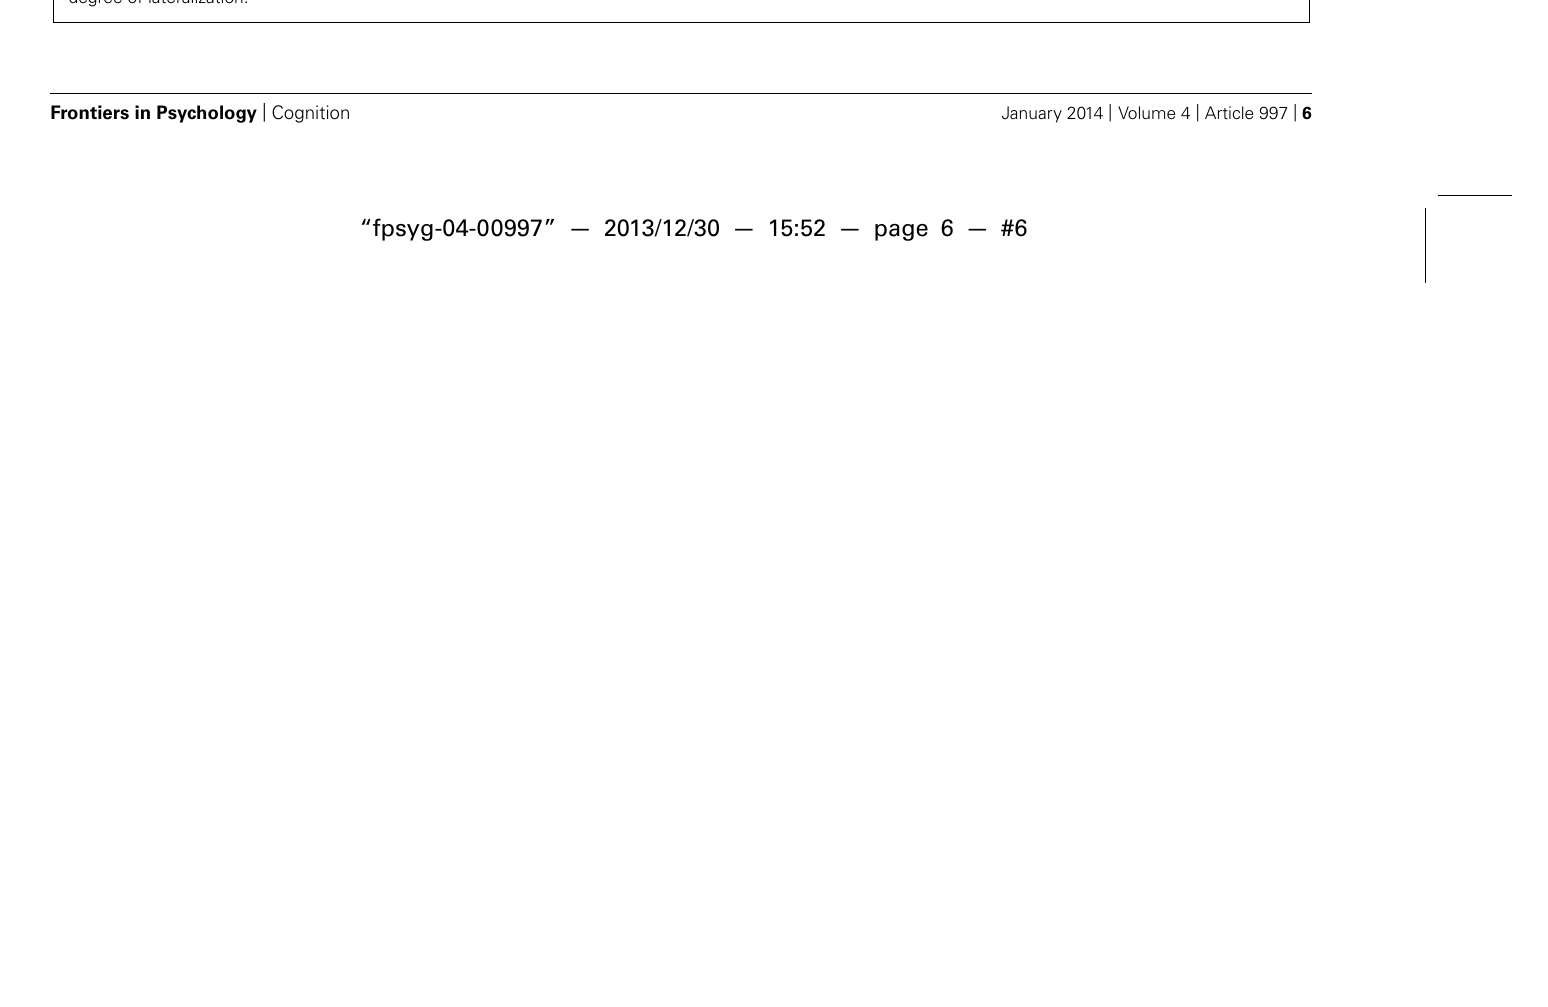
Frontiers in Psychology |